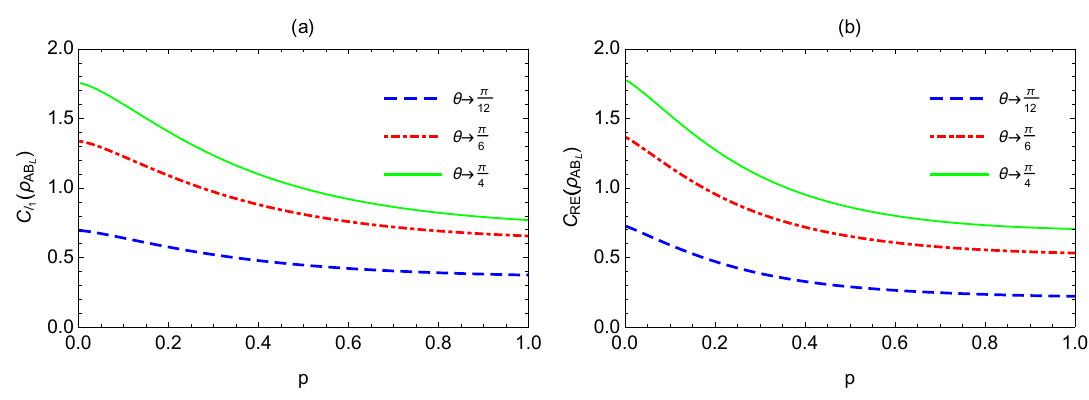
Figure 2 . Quantum coherence C l p for different θ . The mass parameter ν is fixed as ν = 1 / 2